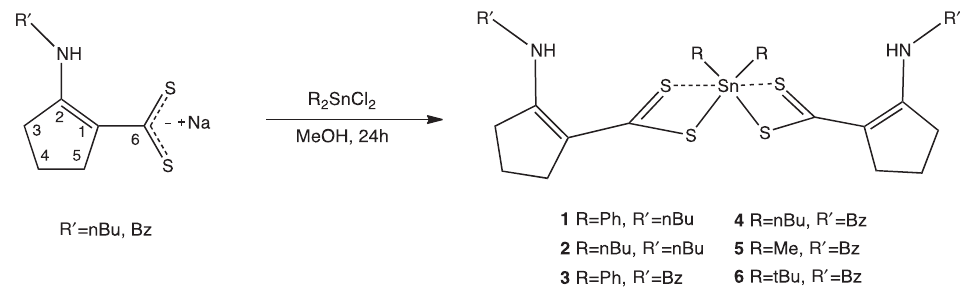
Scheme 2 Synthetic procedure and chemical composition of the compounds 1 –